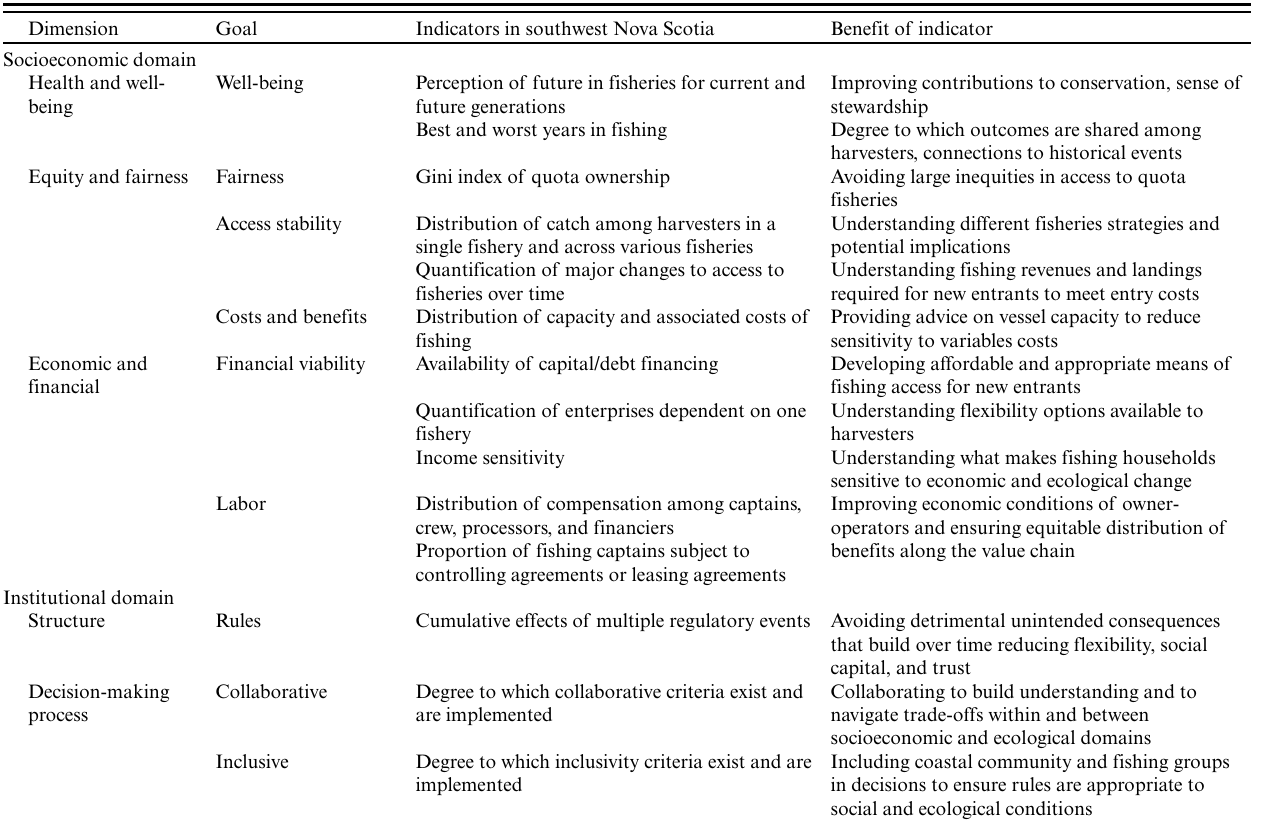
Table 5 . Proposed socioeconomic and institutional indicators from the Canadian Fisheries Research Network Sustainability Framework that could be used to enhance Maritimes lobster Integrated Fisheries Management Plans, based on this study’s